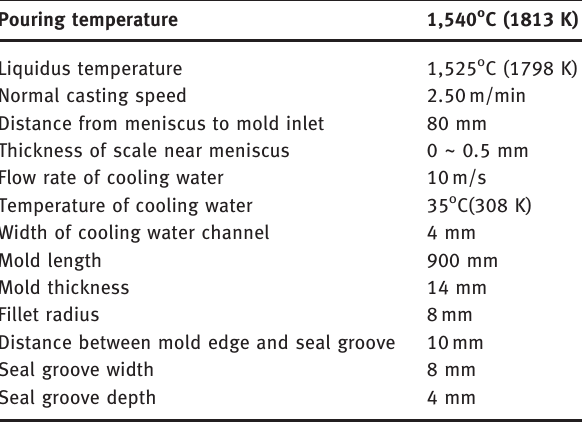
Table 2: Operating conditions and parameters of CC mold. Pouring